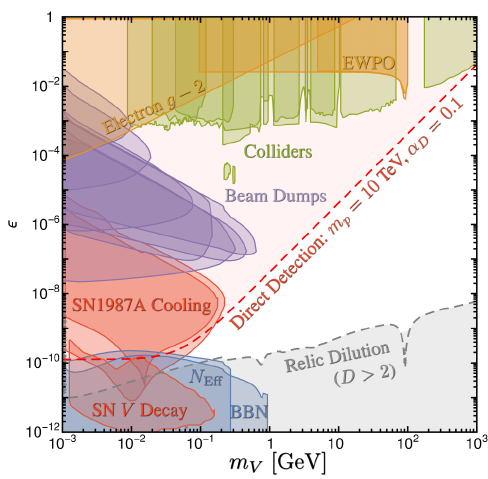
Figure 14: The constraints on the dark photon parameter space. Details of the indi- vidual constraints can be found in the text. The cut-off in the EWPO, BBN, and N constraints is artificial and originates from a limited plot range in [ 73,101,102 ]